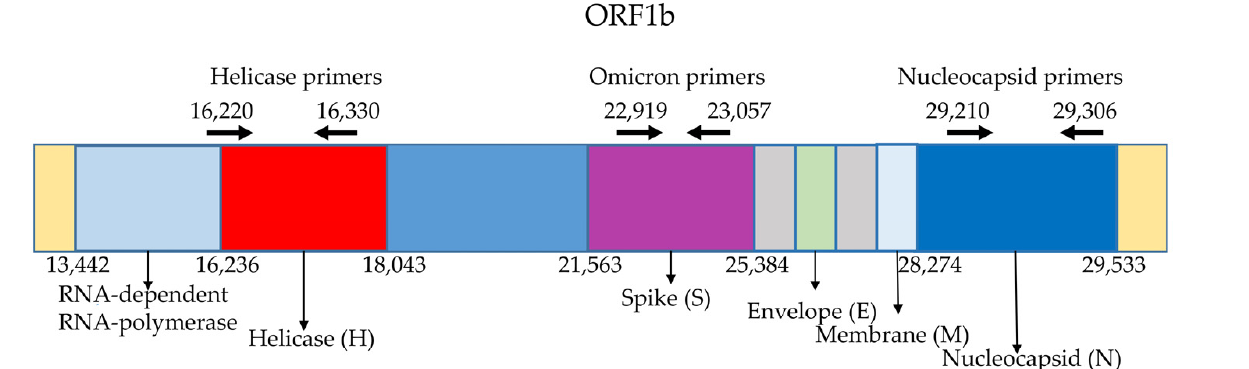
Figure 1. Genome positions of SARS-CoV-2 primers.